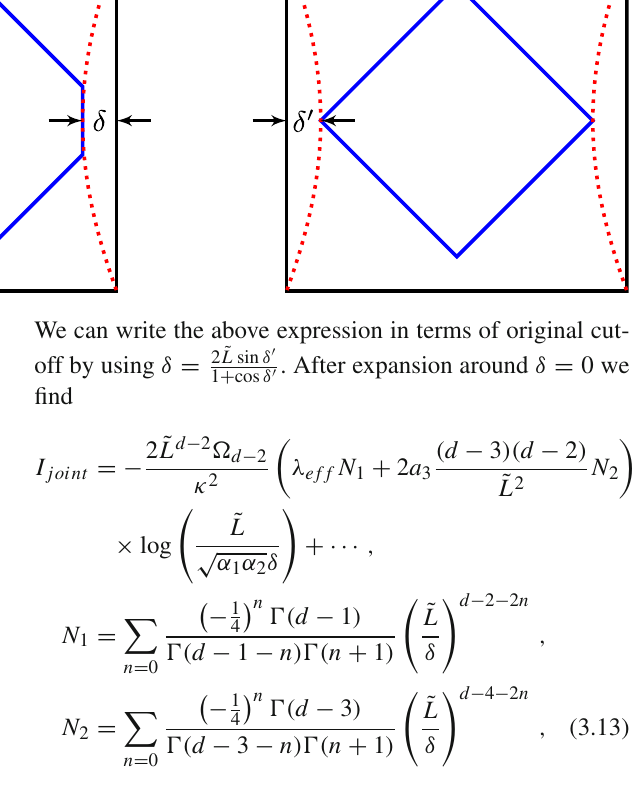
Fig. 3 Two ways for regularizing the WDW